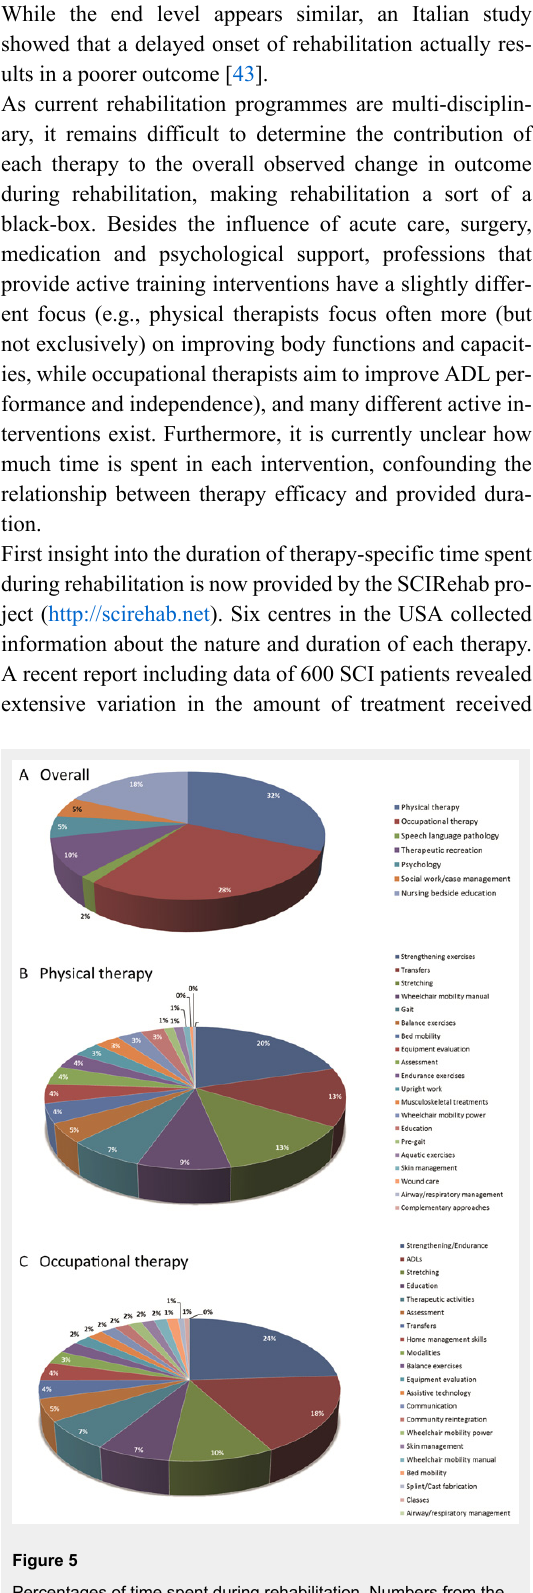
Percentages of time spent during rehabilitation. Numbers from the SCIRehab project showing the percentage of time of 600 patients (132 high cervical AIS A, B and C; 151 low cervical AIS A, B and C; 223 paraplegic AIS A, B and C and 94 AIS D patients) spent during rehabilitation. (A), overall distribution of the various disciplines, (B), percentages of time spent in physical therapy activities and